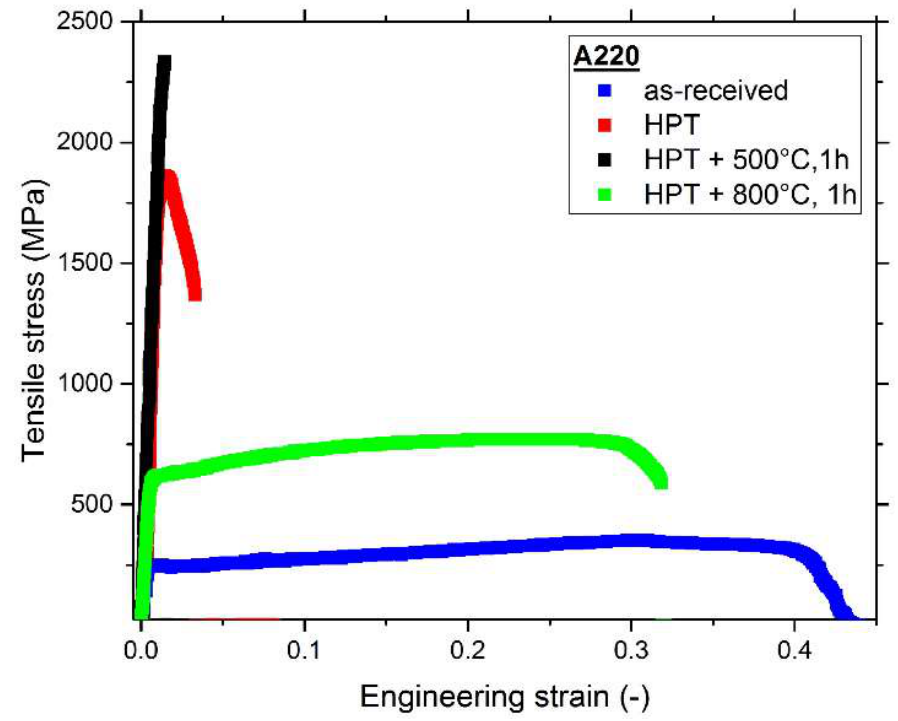
Figure 10. Tensile curves of the as-received state, the nanocrystalline HPT state and two annealed states of the A220 stainless steel.